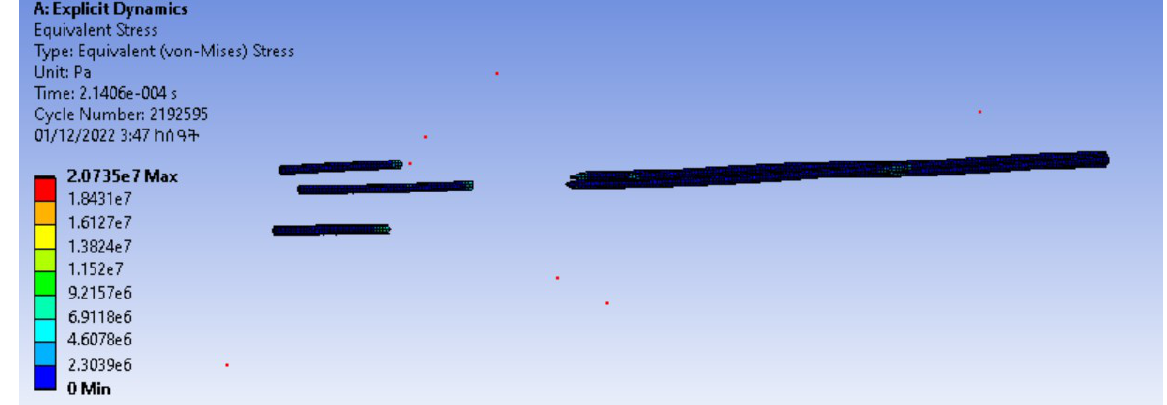
Figure 21. Simulation of the tensile test at a coarser element size.